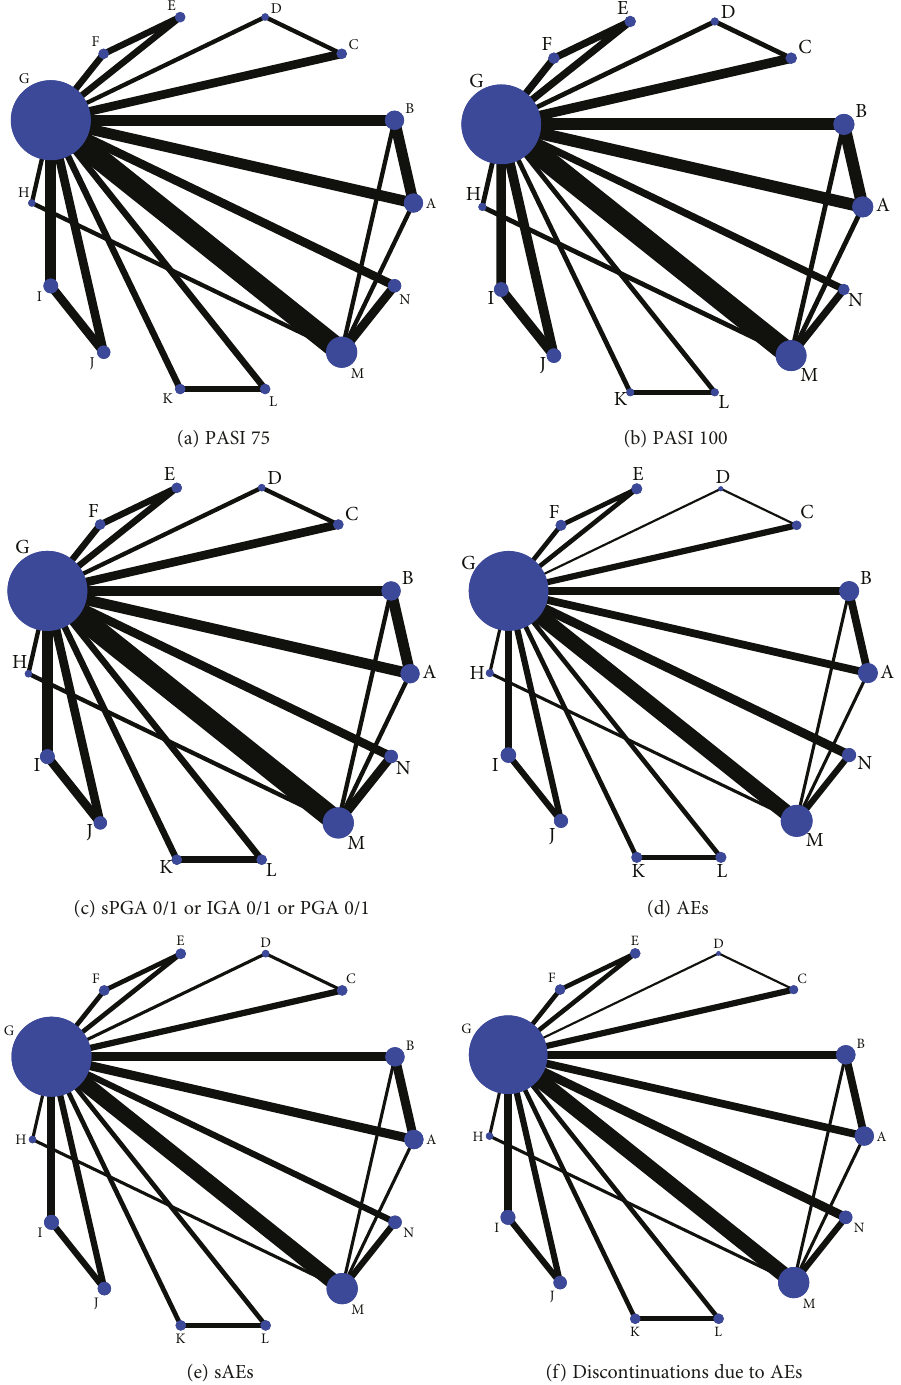
Figure 3: Network plots for all the evaluated outcomes at 12 or 16 weeks. The sizes of the nodes are weighted by the sample of interventions, and the widths of lines are weighed by the number of the studies involved. PASI 75: the percentages of patients with a 75% improvement from baseline in the PASI score; PASI 100: the percentages of patients with a 100% improvement from baseline in the PASI score; sPGA 0/1: static physician ’ s global assessment score of 0 or 1; IGA 0/1: a response of 0 or 1 on the modi fi ed investigator ’ s global assessment; PGA